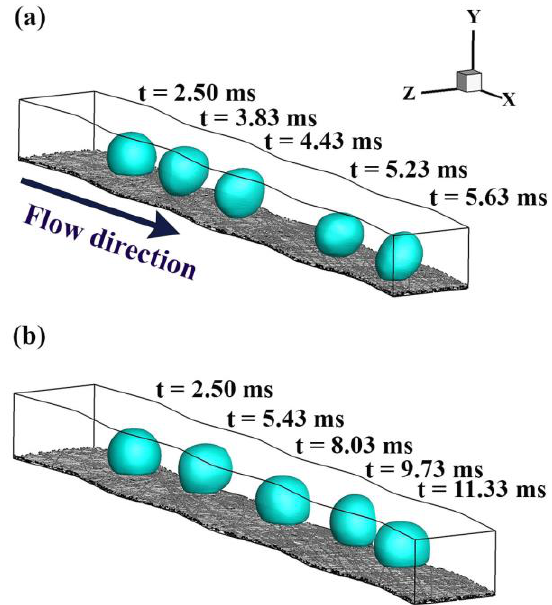
Figure 12. Droplet temporal positions under different superficial inlet velocities ( a ) 10 m s −1 and ( b ) 5 m s −1 , respectively.